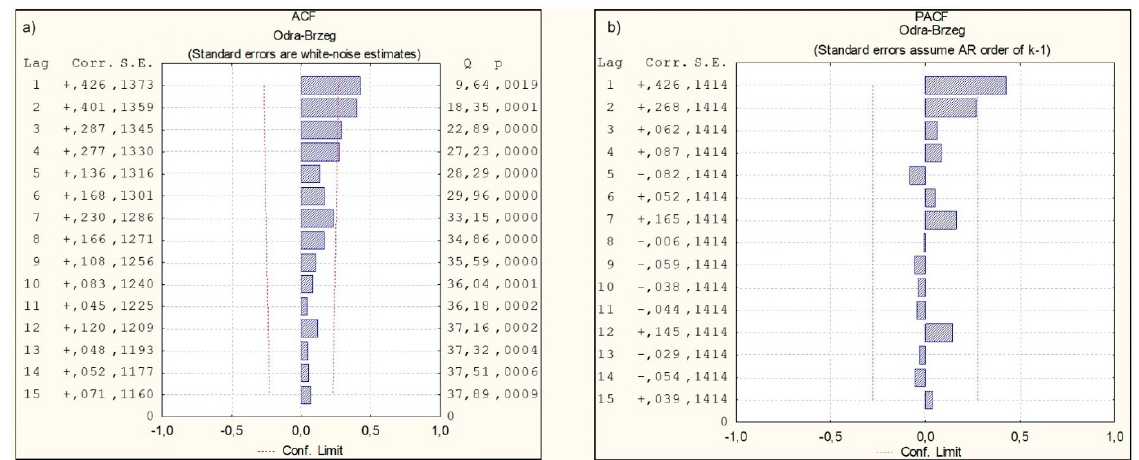
Figure 6. ACF ( a ) and PACF ( b ) of the average annual water temperature for station Oder-Brzeg (Cols: Lag, Correlation, Standard Error, Q and P—